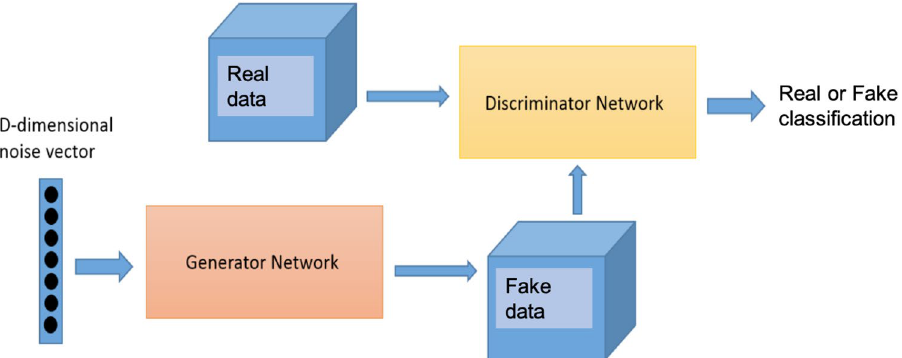
Figure 1. GAN architecture used as reference